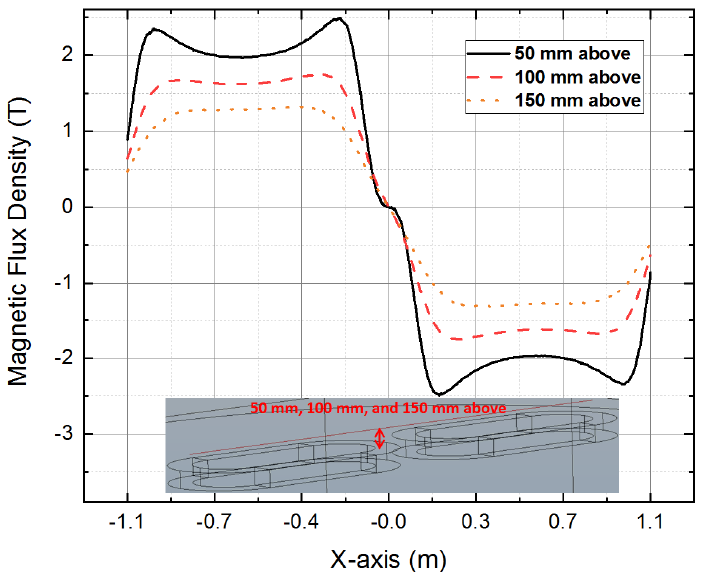
Figure 5. Magnetic flux density in the z -direction ( B z ) along the reference lines at 50, 100, and 150 mm above the HTS magnets with an operating current of 350 A.